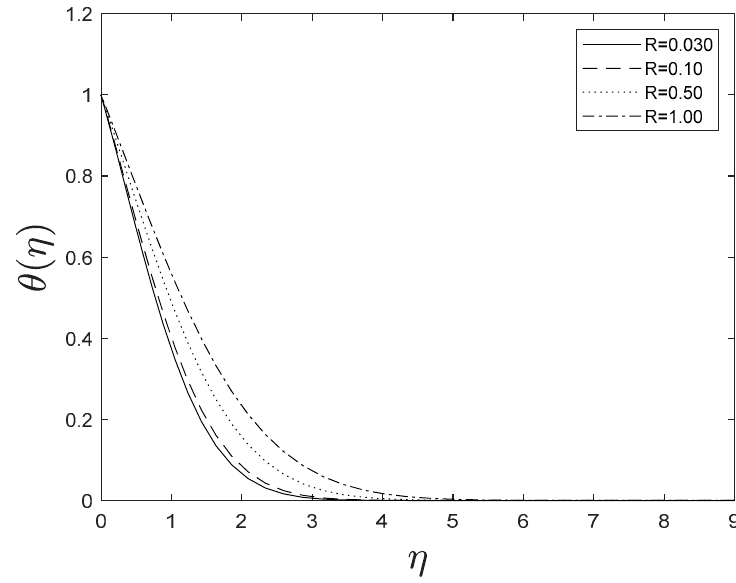
Figure 15. Effect of different values of R on θ ( ζ )